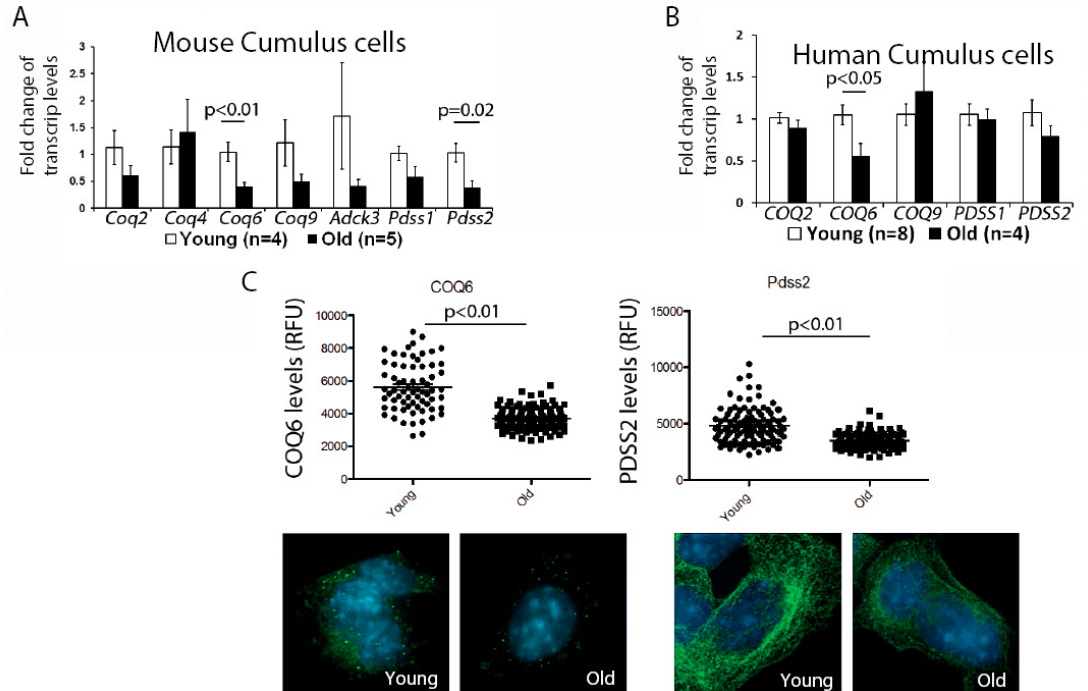
Figure 1. Expression of genes involved in the Co-enzyme Q (CoQ) synthesis, in young and old cumulus cells. ( A ) Fold change in the mRNA levels in the cumulus cells, with aging. Most CoQ10 synthesis gene expression, decreased with aging, with significant impact on the Coq6 and Pdss2 . Cumulus cells were stripped from the ovulated oocytes and pooled, per female, from young ( n = 4) and old mice ( n = 5). β -actin was used as a housekeeping gene. ( B ) Fold change in mRNA levels in the CoQ10 synthesis genes, from human cumulus cells pooled from several oocytes of the same patient. The cells were striped from the oocytes, prior to Intra Cytoplasmic Sperm Injection ICSI, pooled, and analyzed, similar to murine cumulus cells. Significant decrease for the CoQ6 was observed. ( C ) Immunocytochemistry with anti-CoQ6 and Pdss2 antibodies in cumulus cells from young and old mice. Reduced levels of both of these proteins in the cumulus cells, with aging, was observed. Values represent the mean fluorescence units ± SEM measured, per cell, where each dot represents a fluorescent intensity per cumulus cell, obtained by pooling cells from three different females, analyzing 60–100 cells per group (magnification 100×).